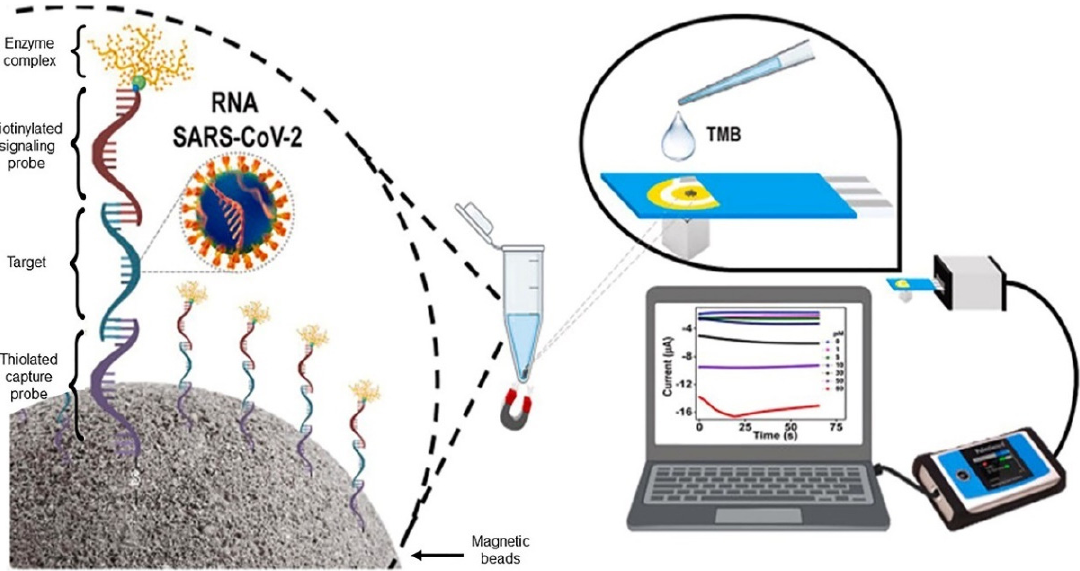
Figure 7. Nucleic acid-based electrochemical biosensors for SARS-CoV-2 detection. SPAuE-based sandwich-type genosensor modified with magnetic beads for RNA detection. Reproduced with permission from [57], with modifications. Copyright 2022, Elsevier.